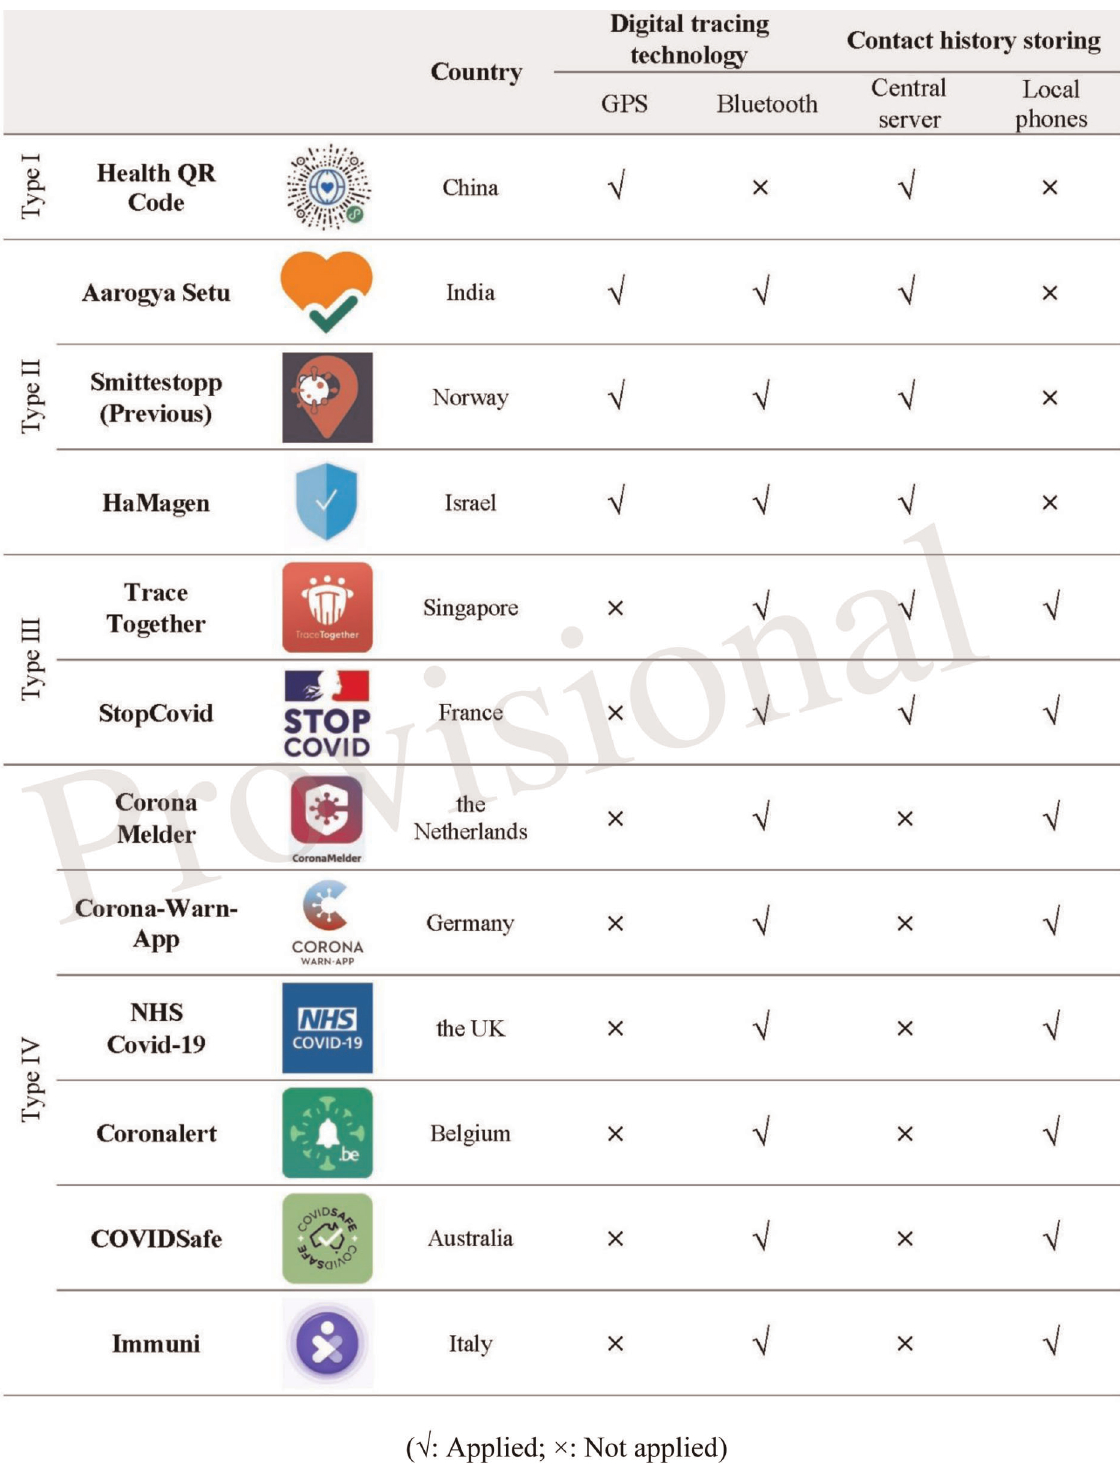
TABLE 1 A comparison of different apps on their basic